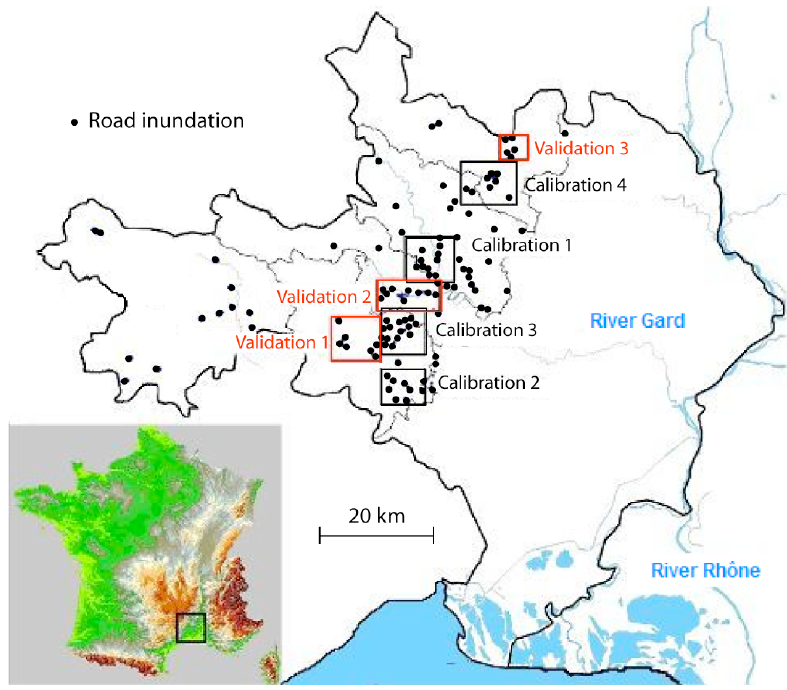
Fig. 1. The Gard Region, the four calibration (black rectangles) and the three validation areas (red rectangles) and the location of the road inundations reported in the PICH database